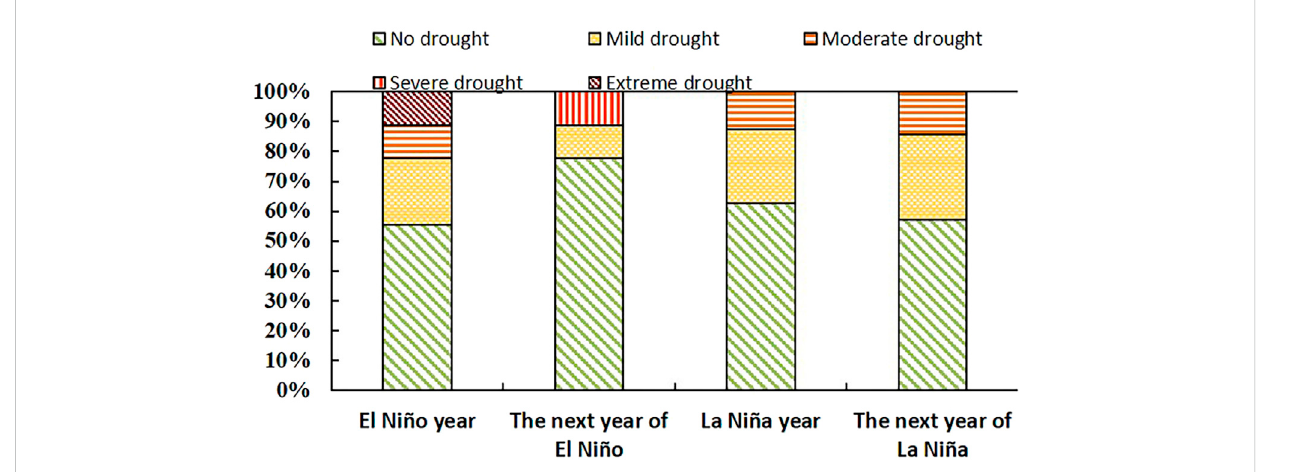
FIGURE 8 Percentages of drought years in El Niño/La Niña and the following year.